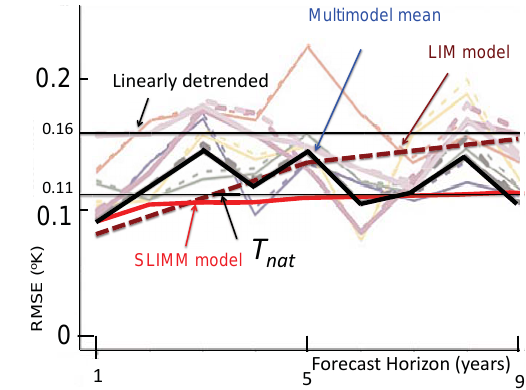
Figure 2. ENSEMBLES experiment, LIM and SLIMM hindcasts for global annual temperatures for horizons of 1 to 9 years. The light lines are from individual members of the ENSEMBLE ex- periment; the heavy line is the multimodel ensemble adapted from Fig. 4 in García-Serrano and Doblas-Reyes (2012). This shows the RMSE comparisons for the global mean surface temperatures com- pared to NCEP/NCAR (2m air temperatures). Horizontal reference lines indicate the standard deviations of T nat (bottom panel) and of the linearly detrended temperatures (top panel). Also shown are the RMSE for the LIM model (from Table 1 in Newman, 2013) and the